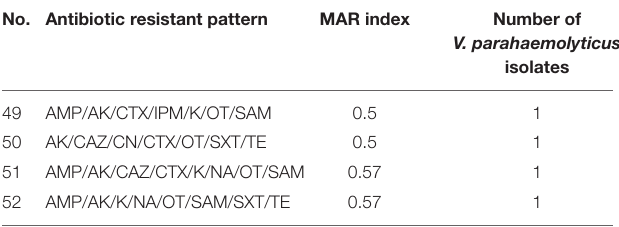
TABLE 3 | Antibiogram and multiple antimicrobial resistance (MAR) indices of V. parahaemolyticus isolates.